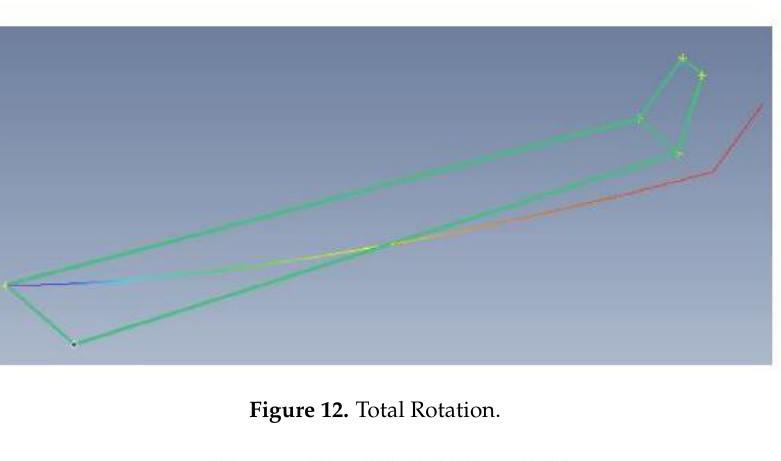
Figure 11. Total Translation.